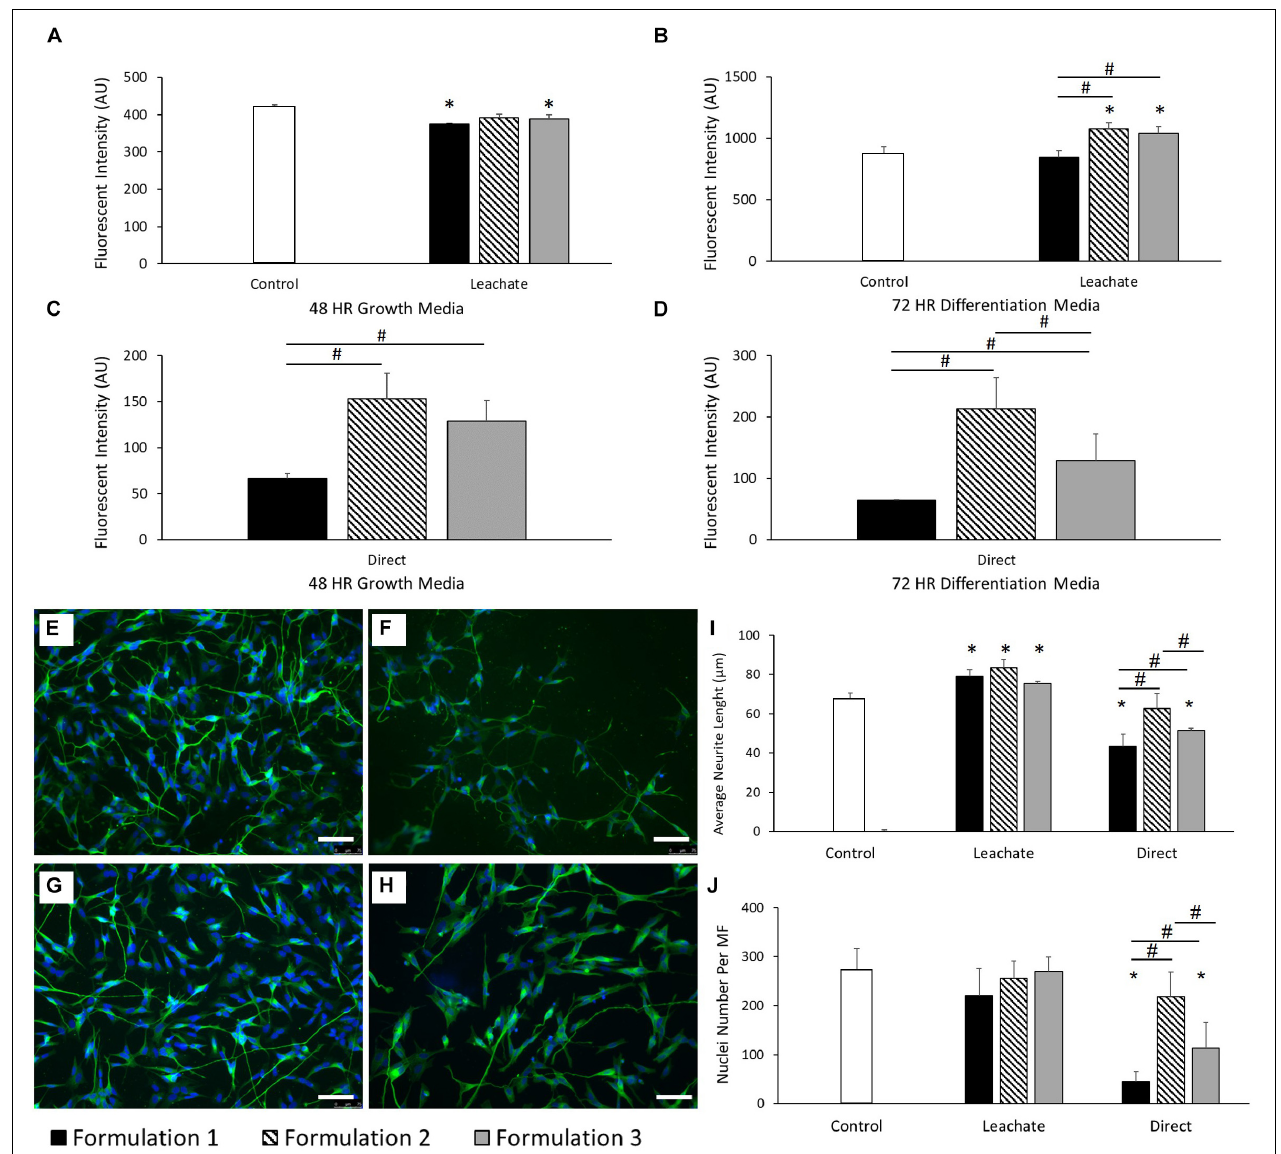
FIGURE 2 | (A) Cellular viability of SH-SY5Y neuroblastoma cells cultured in the chemical leachate of PEDOT:PSS coated glass substrates after 48 h in neuronal GM. (B) Cellular viability of SH-SY5Y neuroblastoma cells cultured in the chemical leachate of a PEDOT:PSS glass substrates after 72 h in neuronal DM. (C) Cellular viability of SH-SY5Y neuroblastoma cells cultured directly onto a PEDOT:PSS glass substrates after 48 h in neuronal GM. (D) Cellular viability of SH-SY5Y neuroblastoma cells cultured directly onto a PEDOT:PSS glass substrates after 72 h in neuronal DM. Data presented as mean ± SD from n = 6 experimental repeats in each condition. # significantly different within group, * significantly different from control ( P < 0.05). (E–H) Morphological staining of SH-SY5Y neuroblastoma cells cultured directly on PEDOT:PSS coated glass substrates: (E) uncoated glass control, (F) formulation 1, (G) formulation 2, (H) Formulation 3. Green = β -tubulin, blue = DAPI. Scale bar = 100 µ m. (I) Average neurite length of SH-SY5Y neuroblastoma cells after 72 h in DM, cultured in both the chemical leachate of a PEDOT:PSS coated glass substrate and directly onto the material. (J) Nuclei number per microscope field (MF, 20 × magnification) of SH-SY5Y neuroblastoma